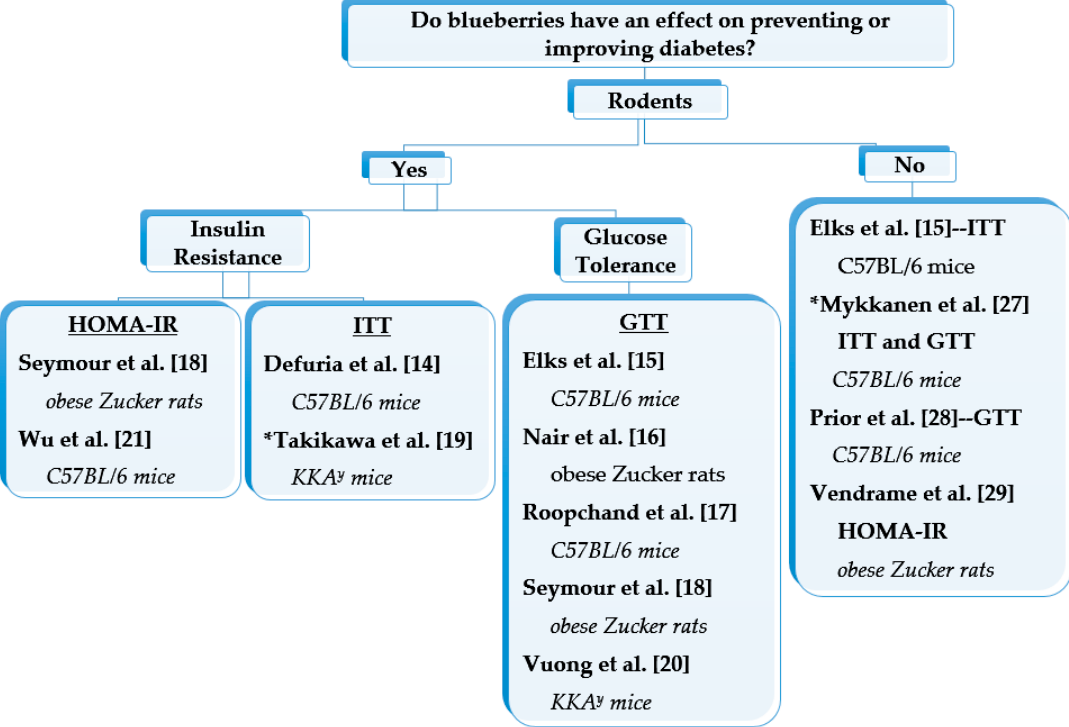
Figure 1. The effect of blueberries on preventing and improving type 2 diabetes in obese C57BL/6 mice, KKA y mice, and Zucker rats. The rodents were fed blueberries for over 3 weeks and insulin resistance and/or glucose tolerance were assessed using HOMA-IR (homeostatic model assessment-estimated insulin resistance), ITT (insulin tolerance test), and GTT (glucose tolerance test). Seymour et al. [18], Mykkanen et al. [27], and Elks et al. [15] evaluated insulin resistance and glucose tolerance. * Studies that used bilberries.